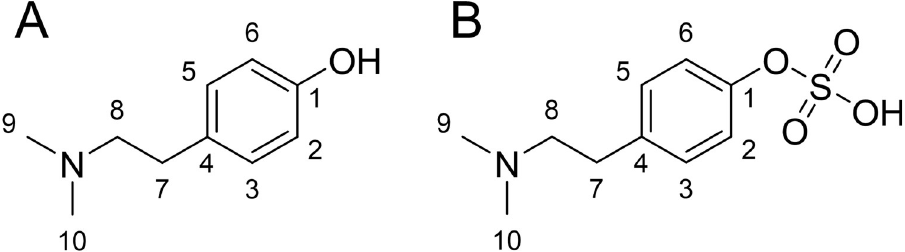
Fig 1. Chemical structures of hordenine (A) and its metabolite hordenine sulfate